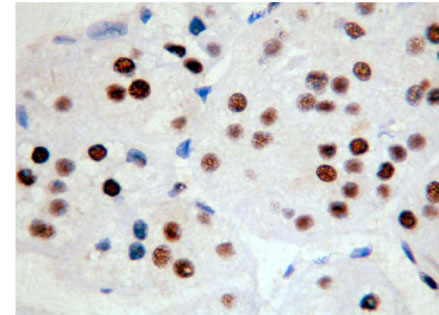
Adrenocortical adenoma PCNA (+ +) SuperisionTM two footworks